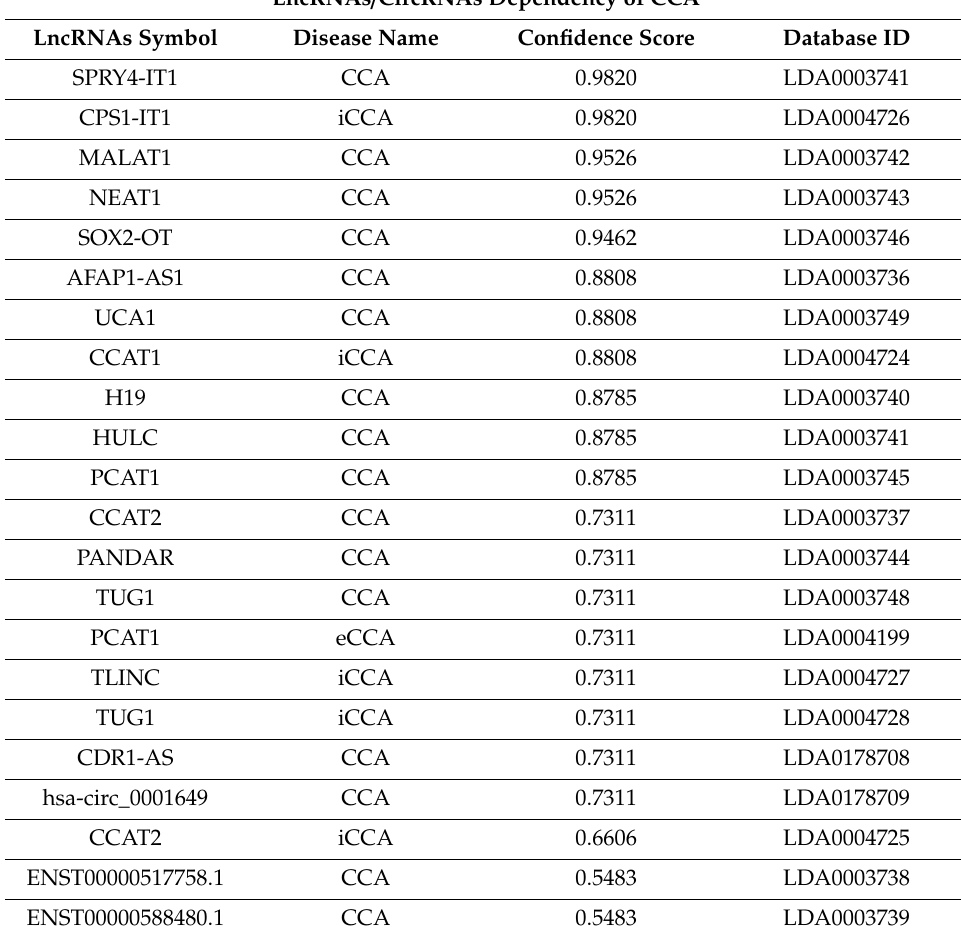
Table 3. Most significant LncRNAs / CircRNAs are related to the tumorigenesis of CCA. All candidates from LncRNADisease website (version